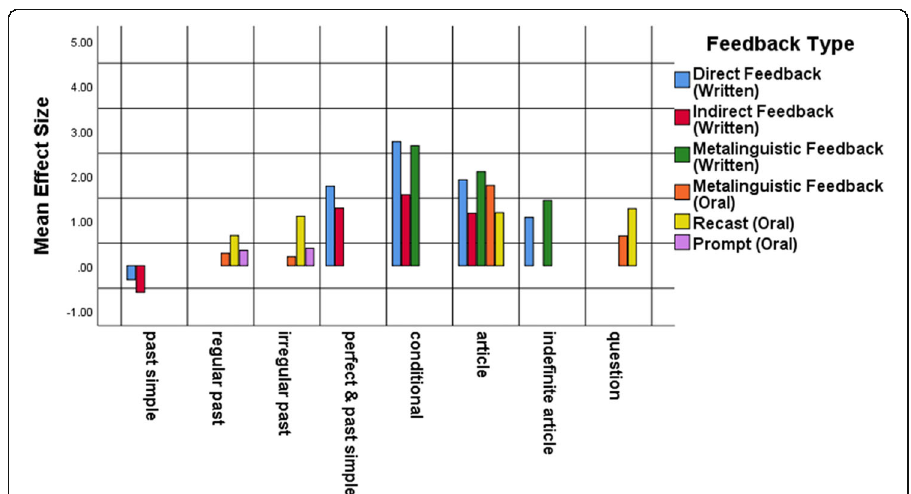
Fig. 1 The effect of corrective feedback types on different grammatical